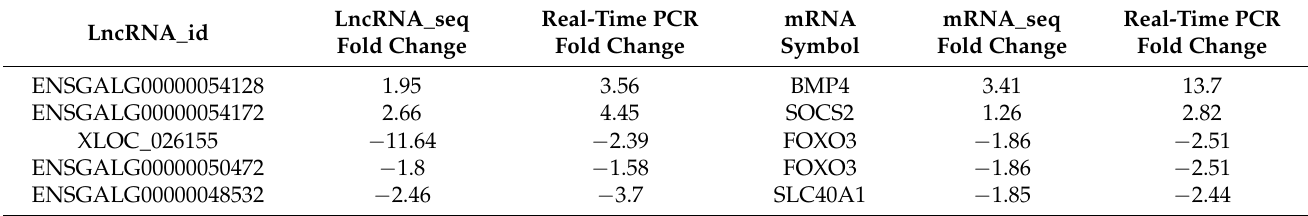
Table 4. Validation of the LncRNA–mRNA pairs by